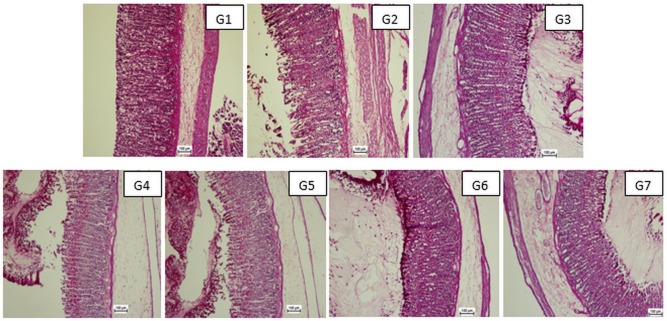
Effects of V. pubescens on gastric tissue glycoprotein-PAS staining in ethanol-induced gastric injury rats.(G1) (Normal control group); (G) (Ulcer control group); (G3) (Omeprazole); (G4) (62.5 mg/kg), (G5) (125 mg/kg), (G6) (250 mg/kg) and (G7) (500 mg/kg) of V. pubescens extract. Animals pre-treated with omeprazole or V. pubescens extract exhibited intense glycoprotein staining (white arrow) (PAS stain magnification 20×). There were 6 rats in each group of experiment.